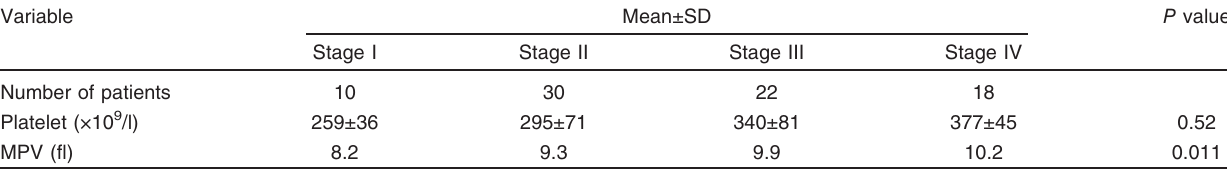
Table 4 Correlation between MPV and grade of severity of stable COPD Variable